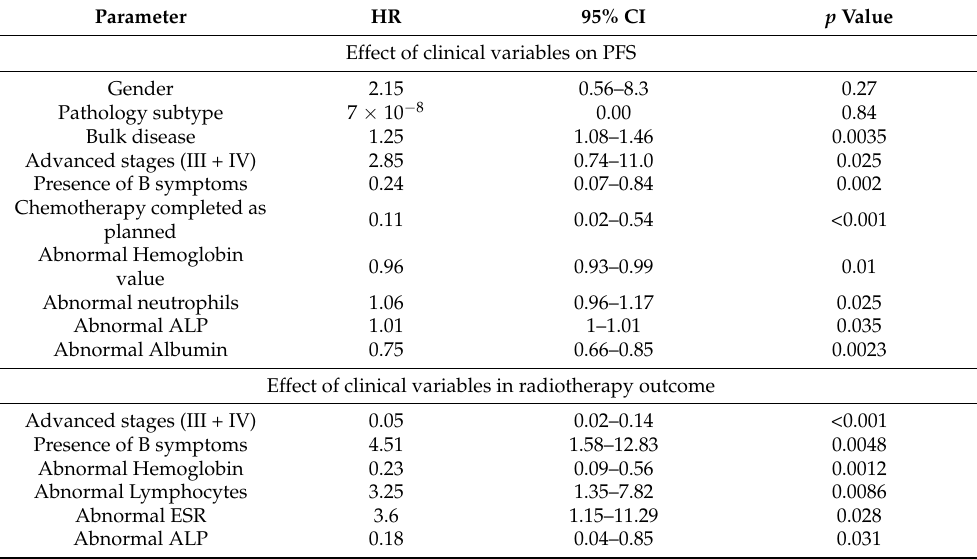
Table 5. Univariate analysis (UVA) summary of statistically significant variables for Clinical parame- ters when correlated with PFS and radiotherapy prediction.